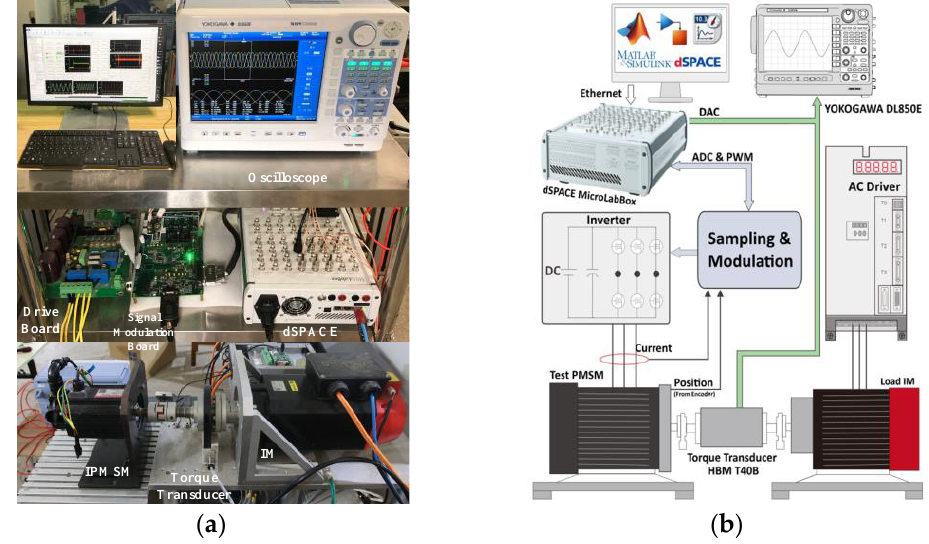
Figure 11. ( a ) Experimental platform. ( b ) Block diagram of the platform.